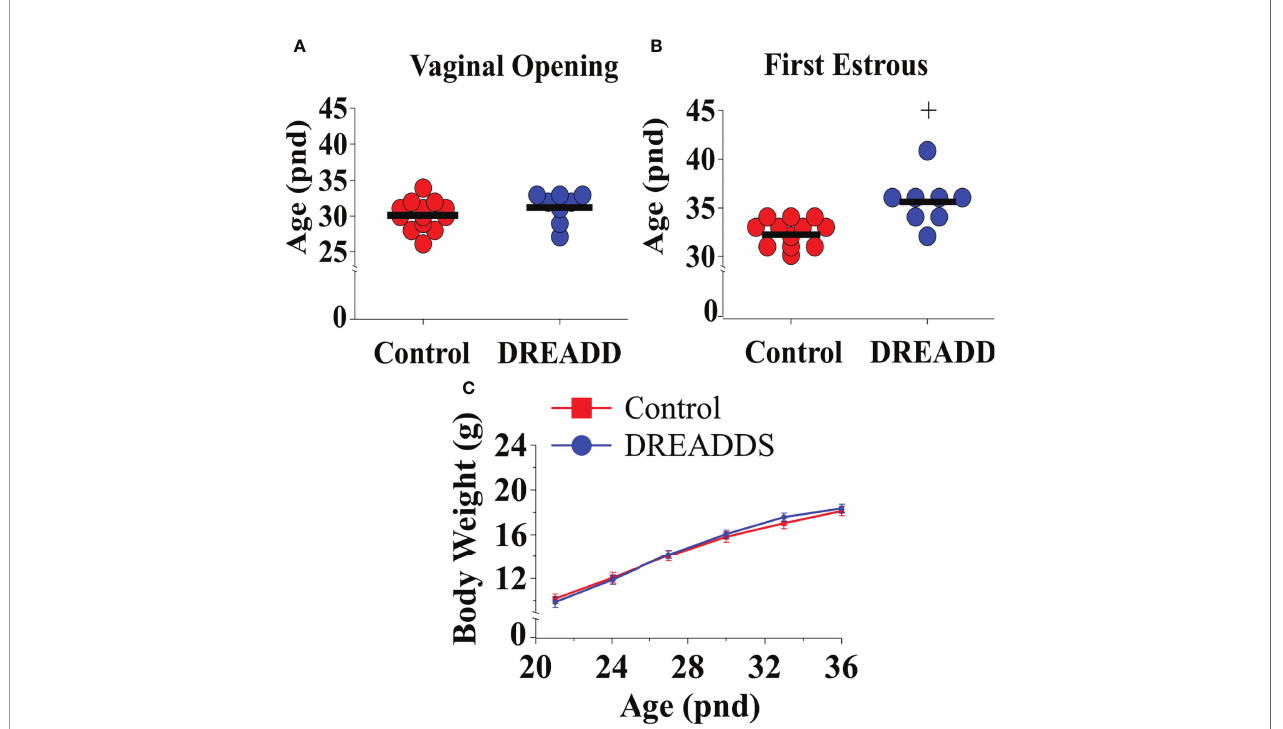
FIGURE 7 | DREADD (hM3D) activation of urocortin 3 (Ucn3) neurons in the posterodorsal sub-nucleus of the medial amygdala (MePD) of Ucn3-cre-tdTomato female mice from post-natal day (pnd) 21 for 14 days delayed fi rst estrous (FE) without affecting vaginal opening (VO) and body weight (BW) in urocortin3-cre- tdTomato female mice. Effect of MePD Ucn3 activation on day of VO (A) , FE (B, C) BW weight gain between pnd 21 and 45. F (1,19) =14.61, +p<0.05 of control group (combined control AAV: n=6; cre-negative control: n=4; no CNO: n=3) vs DREADD group